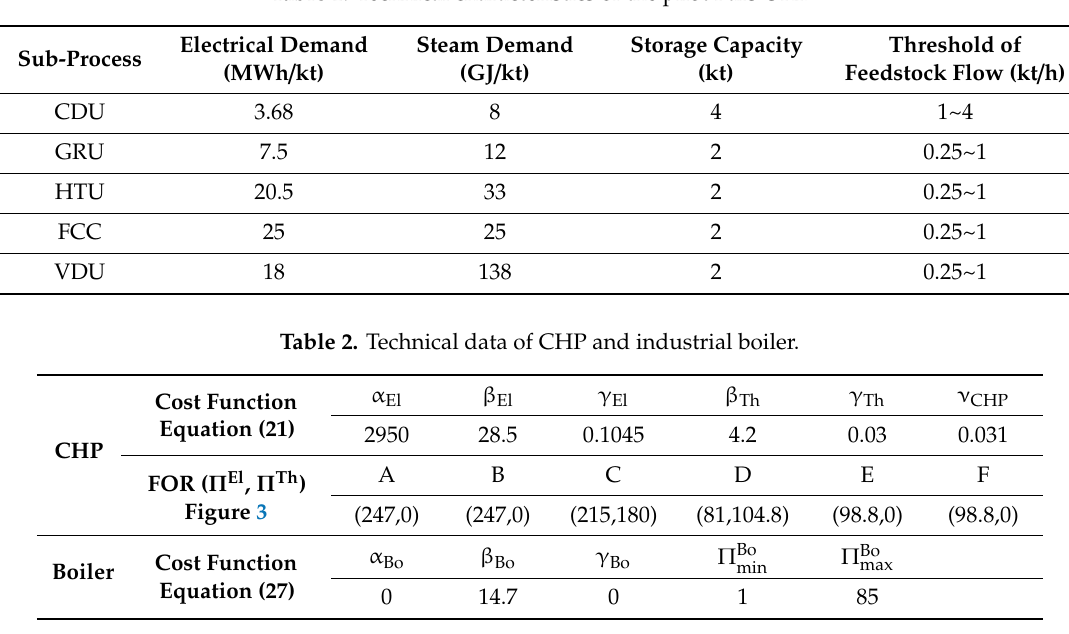
Table 1. Technical characteristics of the pilot Pars ORI.